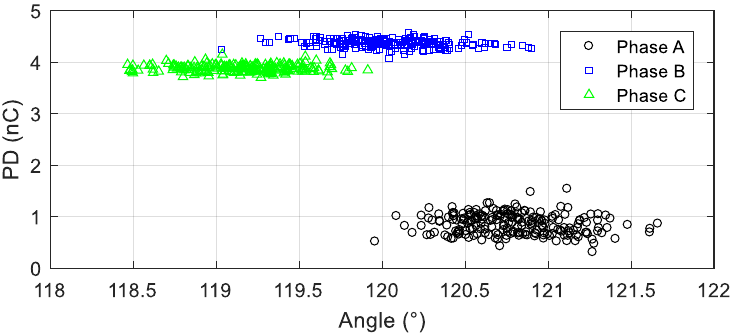
Figure 24. Phase angles of PD occurrences.